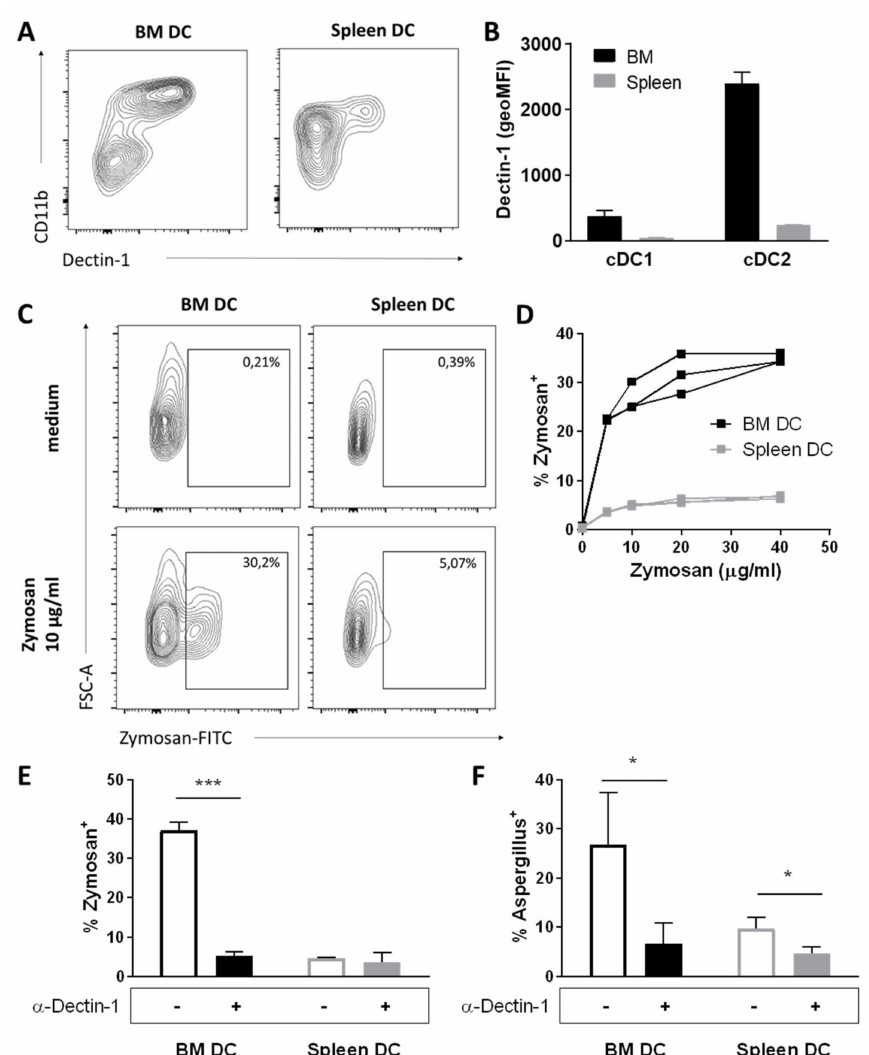
Figure 3. BM DCs express high, functional protein levels of the c-type lectin receptor Dectin-1. ( A ) Representative FACS plots and ( B ) quantification of geoMFI for expression of Dectin-1 by subsets in BM and spleen, as determined by flow cytometry (Mean ± SD, n = 2). ( C ) Representative FACS plots and ( D ) quantification of zymosan uptake by BM DCs and splenic DCs after 2 h in vitro co-culture ( n = 3, p < 0.0001, 2-way ANOVA). ( E ) Uptake of zymosan particles by BM DCs and splenic DCs after 2 h in vitro co-culture in the presence or absence of a Dectin-1 blocking antibody (Mean ± SD, n = 3, multiple t -tests). ( F ) Uptake of life Aspergillus conidia by BM DCs and splenic DCs after overnight in vitro co-culture in the presence or absence of a Dectin-1 blocking antibody (Mean ± SD, n =3, multiple t -tests). * p < 0.05; *** p <